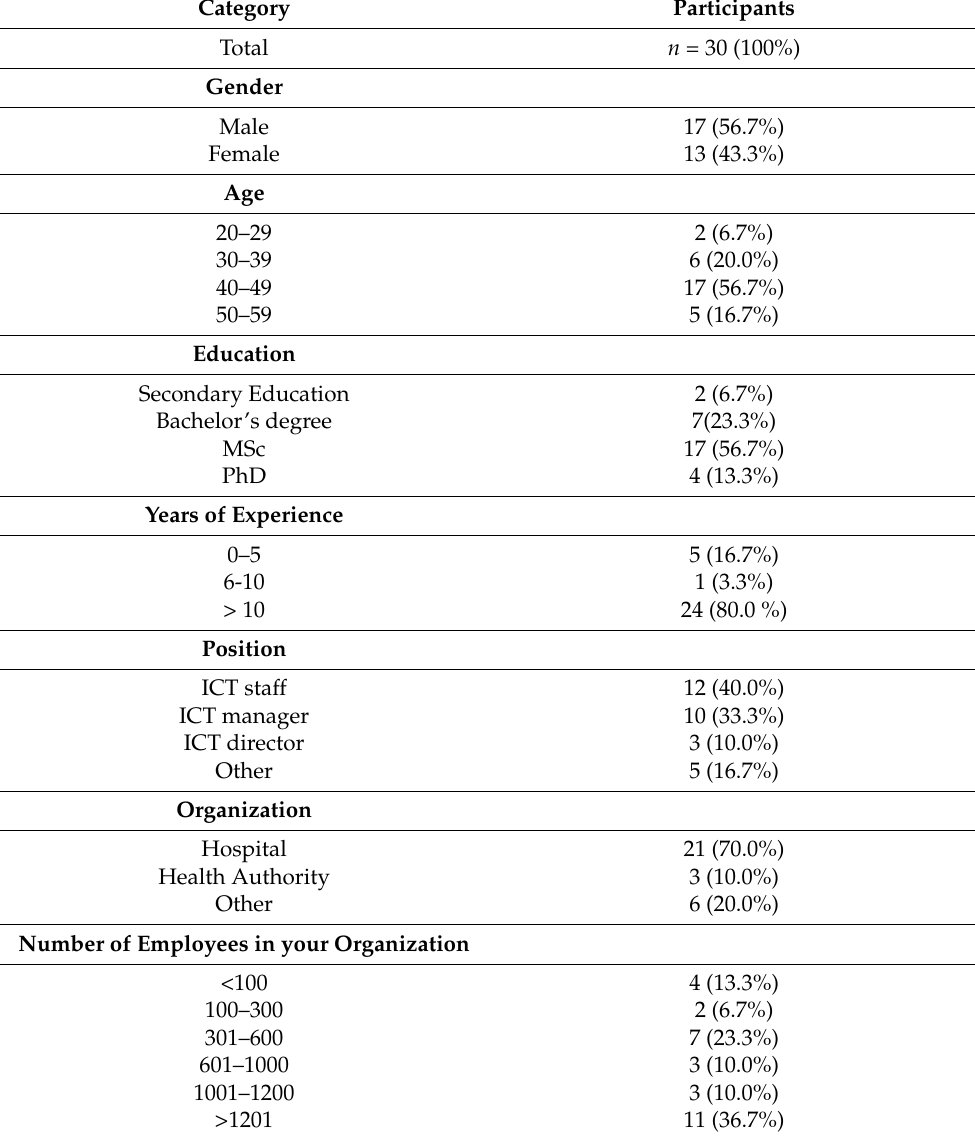
Table 3. Demographics of Workshop Participants That Answered the